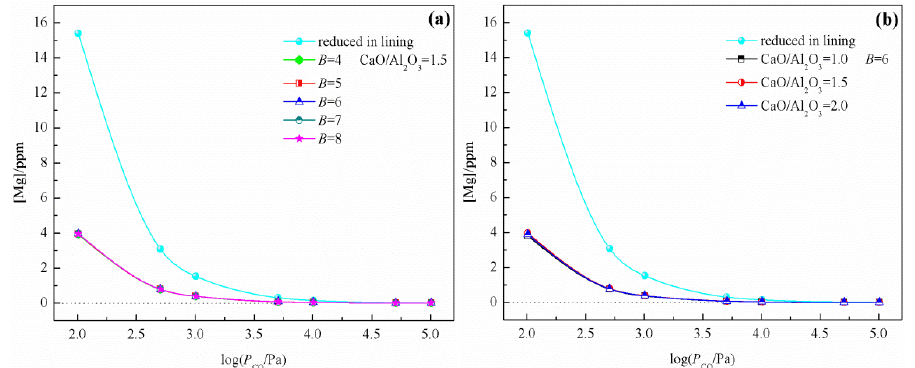
Figure 9. Effects of C on Mg content under RH conditions at different P CO : ( a ) Effect of basicities at a Figure 9. E ff ects of C on Mg content under RH conditions at di ff erent P CO : ( a ) E ff ect of basicities at a fixed CaO/Al 2 O 3 ratio; ( b ) effect of CaO/Al 2 O 3 ratios at a fixed basicity. fixed CaO / Al 2 O 3 ratio; ( b ) e ff ect of CaO / Al 2 O 3 ratios at a fixed